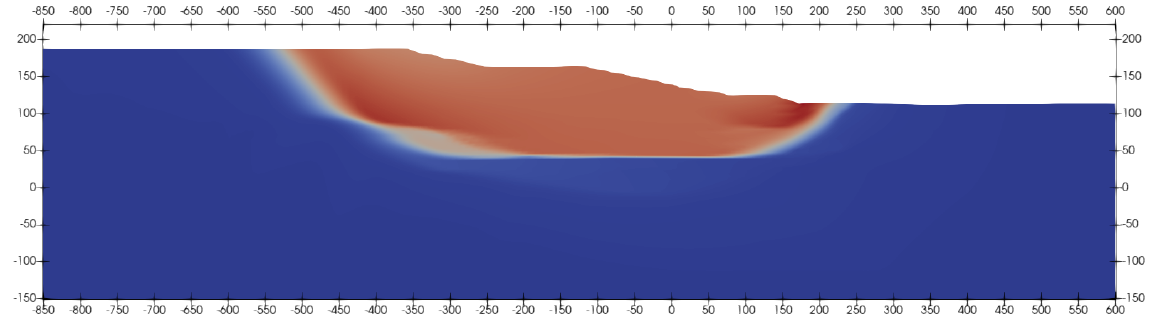
Figure 19: Failure surface at step 230 for dataset IV.